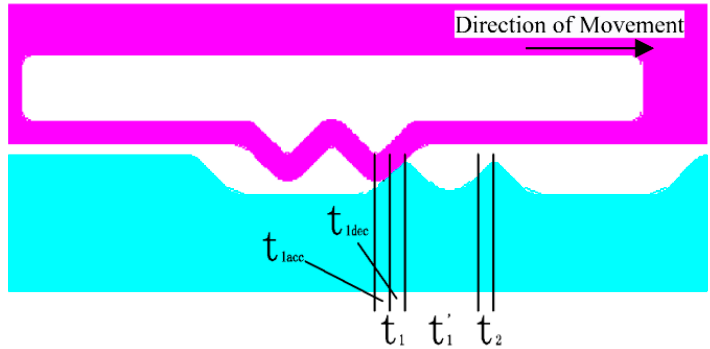
Figure 7. The schematic diagram of kinematic analysis and time estimating.